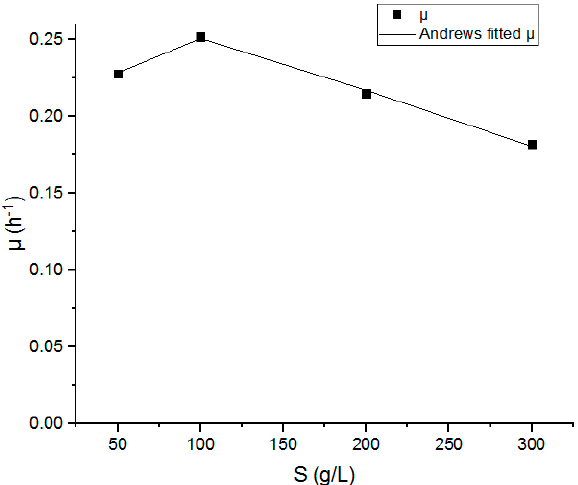
Figure 3. The variation of the specific growth rate μ as a function of the substrate concentration S (50–300 g.L -1 ).